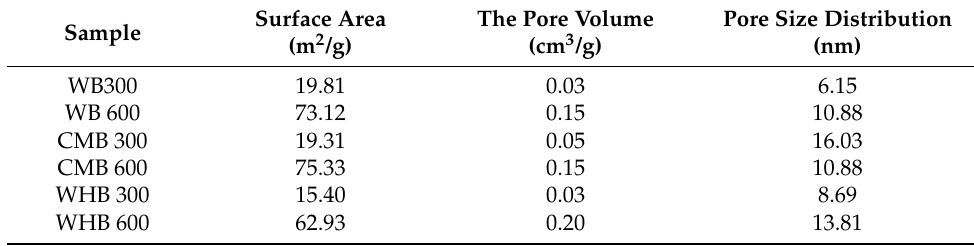
Table 4. Texture properties of